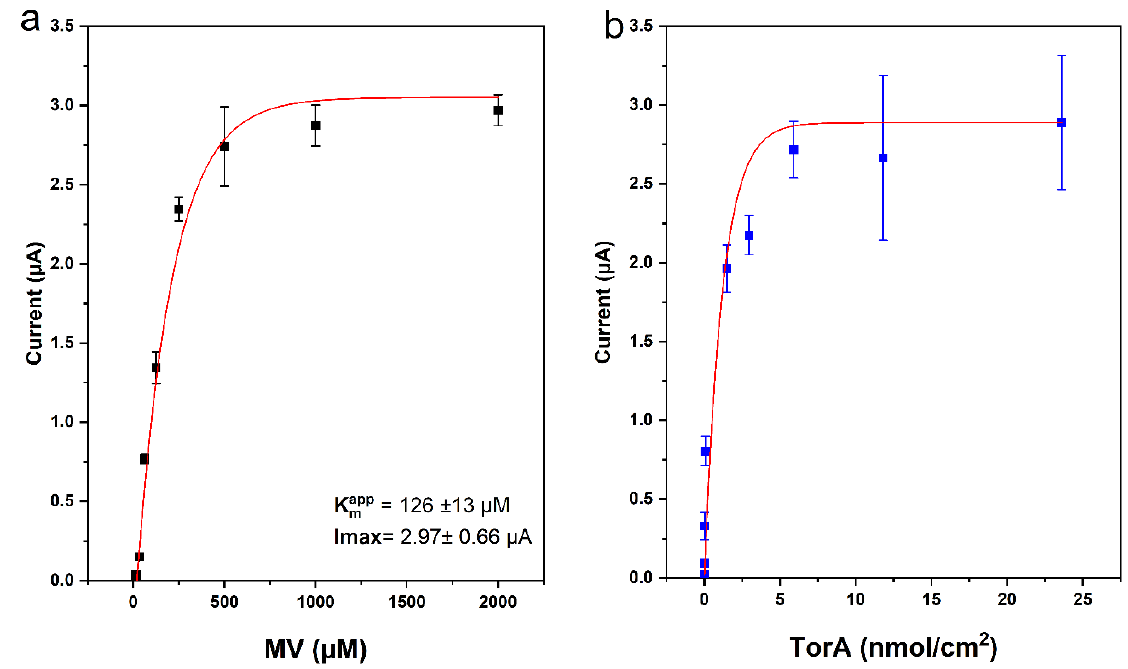
Figure 5. Current response of the TorA/GOD/Cat-electrode as a function of ( a ) methyl viologen concentration and ( b ) TorA surface concentration. Measurements were performed in Sörensen phosphate buffer pH 7 containing 3 mM glucose; 1 mM TMAO in ( a ) TorA 5.9 nmol/cm 2 and in ( b ) 1 mM MV. The O 2 -scavenging membrane contained GOD 10 U, Cat 1000 U, PVA 3%, Eappl = −0.8 V, n = 9 (3 electrodes, three repetitions each).